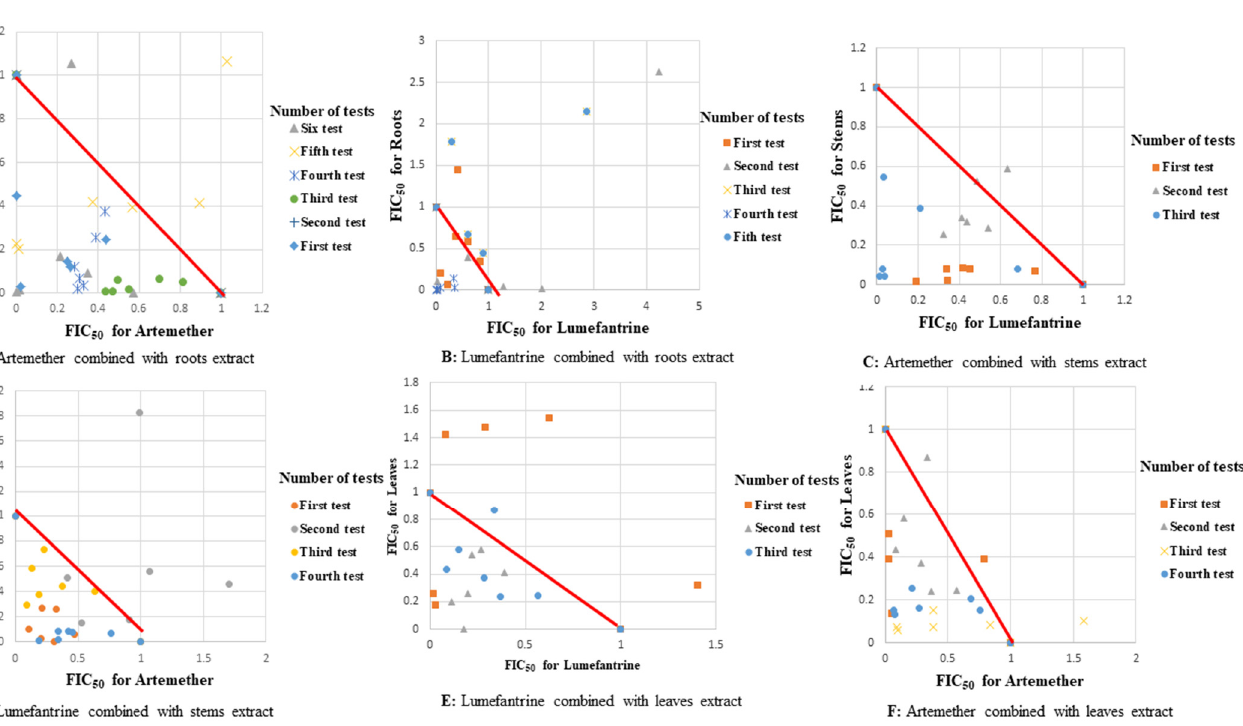
Figure 4. Scatter plots of drugs-extracts combinations against field isolates ex vivo of P. falciparum. Assessment of two of the recommended artemisinin-based combinations at same fixed dose ratio matrices revealed varying responses. Synergism was observed at most fixed dose ratios of artemether-lumefantrine and dihydroartemisinin-piperaquine combinations against field isolates, reference strains of P. falciparum D6 and W2 as well as D6 and W2 (Figure 5).